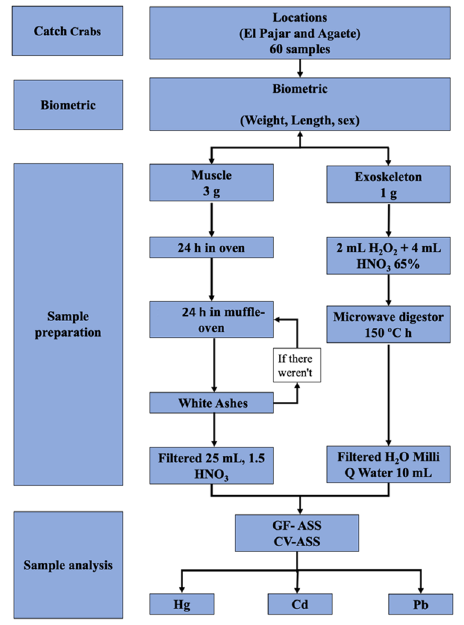
Figure 2. Flowchart of the methodology used.